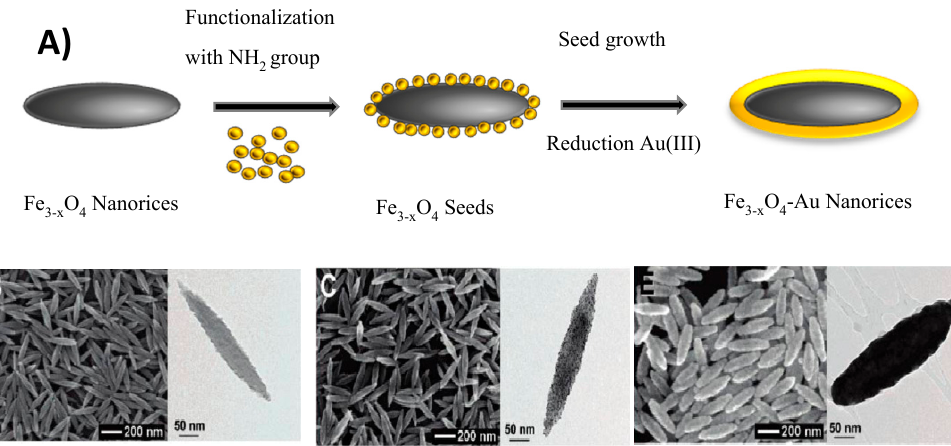
Figure 8. ( A ) Schematic view of the formation of non-spherical core-shell nanoparticles (NPs) starting from anisotropic in shape iron oxide cores. ( B – E ) Scanning electron microscopy (SEM) ( left ) and TEM ( right ) images of ( B ) hematite cores; ( C ) core-satellite particles used as seeds; ( E ) core-shell nanorice particles. Reproduced with permission from [60]. American Chemical Society, 2006.